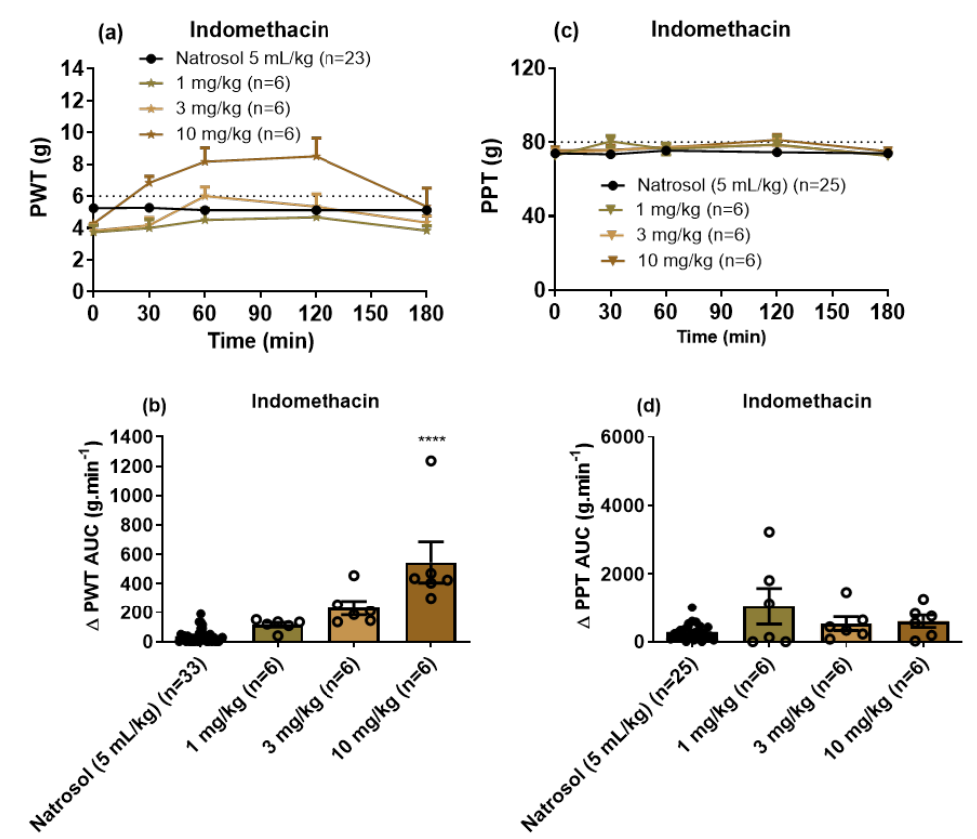
Figure 6. ( a ) Mean ( ± SEM) paw withdrawal threshold (PWT) versus time curves. ( b ) Scatter diagrams of the mean ( ± SEM) extent and duration of action quantified as the mean ( ± SEM) areas under the ∆ PWT versus time curves ( ∆ PWT AUC values) for the combined left and right hindpaws of individual CIPN-rats following the administration of single oral bolus doses of indomethacin at 1 mg/kg (n = 6), 3 mg/kg (n = 6) and 10 mg/kg (n = 6) relative to vehicle (n = 33). The horizontal dotted line in Panel ( a ) indicates fully developed mechanical allodynia (PWT ≤ 6 g). ( c ) Mean ( ± SEM) paw pressure threshold (PPT) versus time curves. ( d ) Scatter diagrams of the mean ( ± SEM) extent and duration of action quantified as the mean ( ± SEM) areas under the ∆ PPT versus time curves ( ∆ PPT AUC values) for the combined left and right hindpaws of individual CIPN-rats following the administration of single oral bolus doses of indomethacin at 1 mg/kg (n = 6), 3 mg/kg (n = 6) and 10 mg/kg (n = 6) relative to vehicle (n = 25). The horizontal dotted line in Panel ( c ) indicates fully developed mechanical hyperalgesia (PPT ≤ 80 g). **** p < 0.0001.